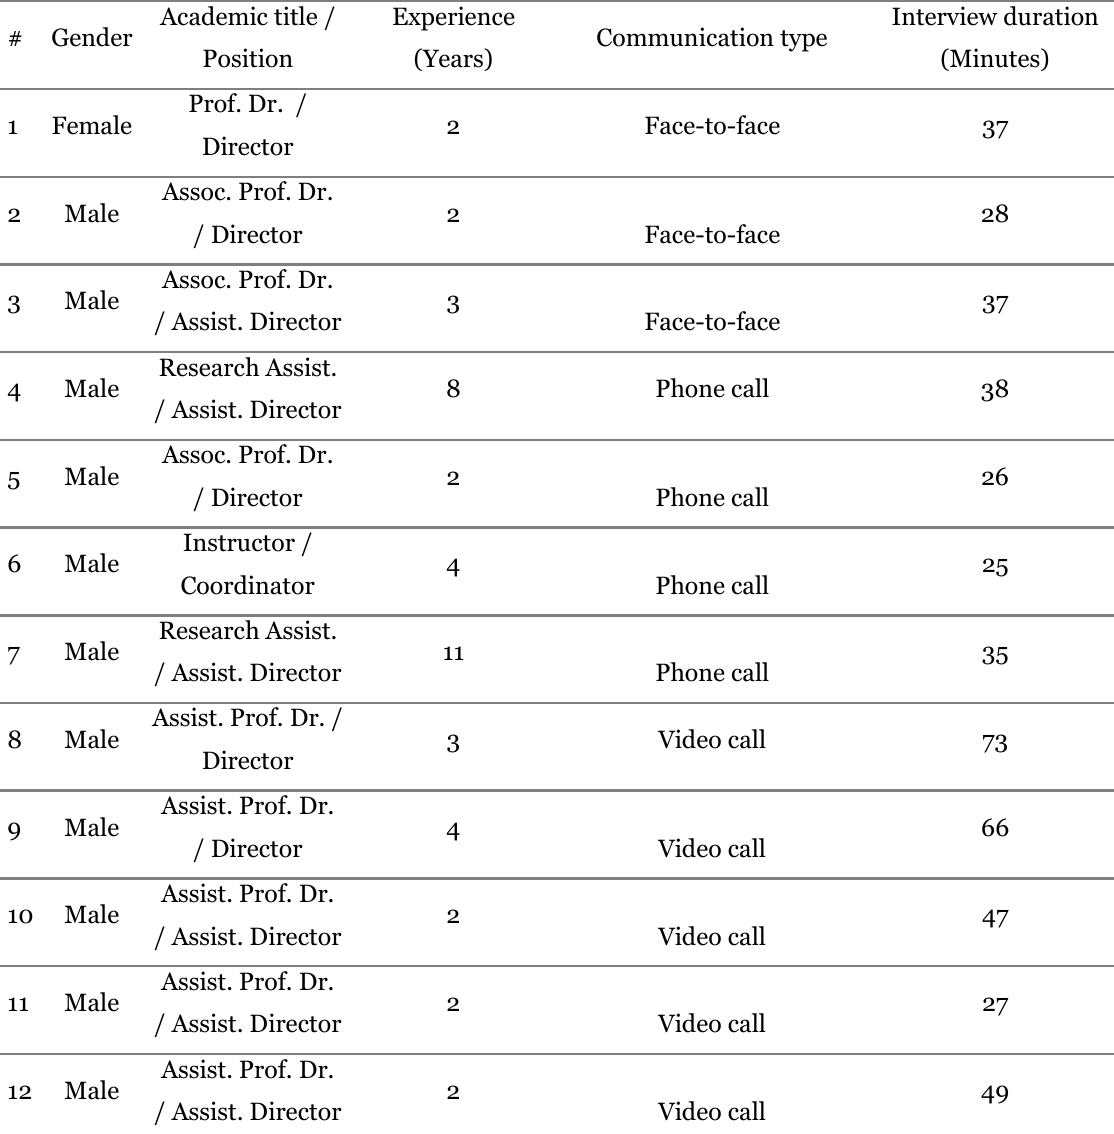
Demographics of the Participants, Communication Types, Interview Durations, Locations,